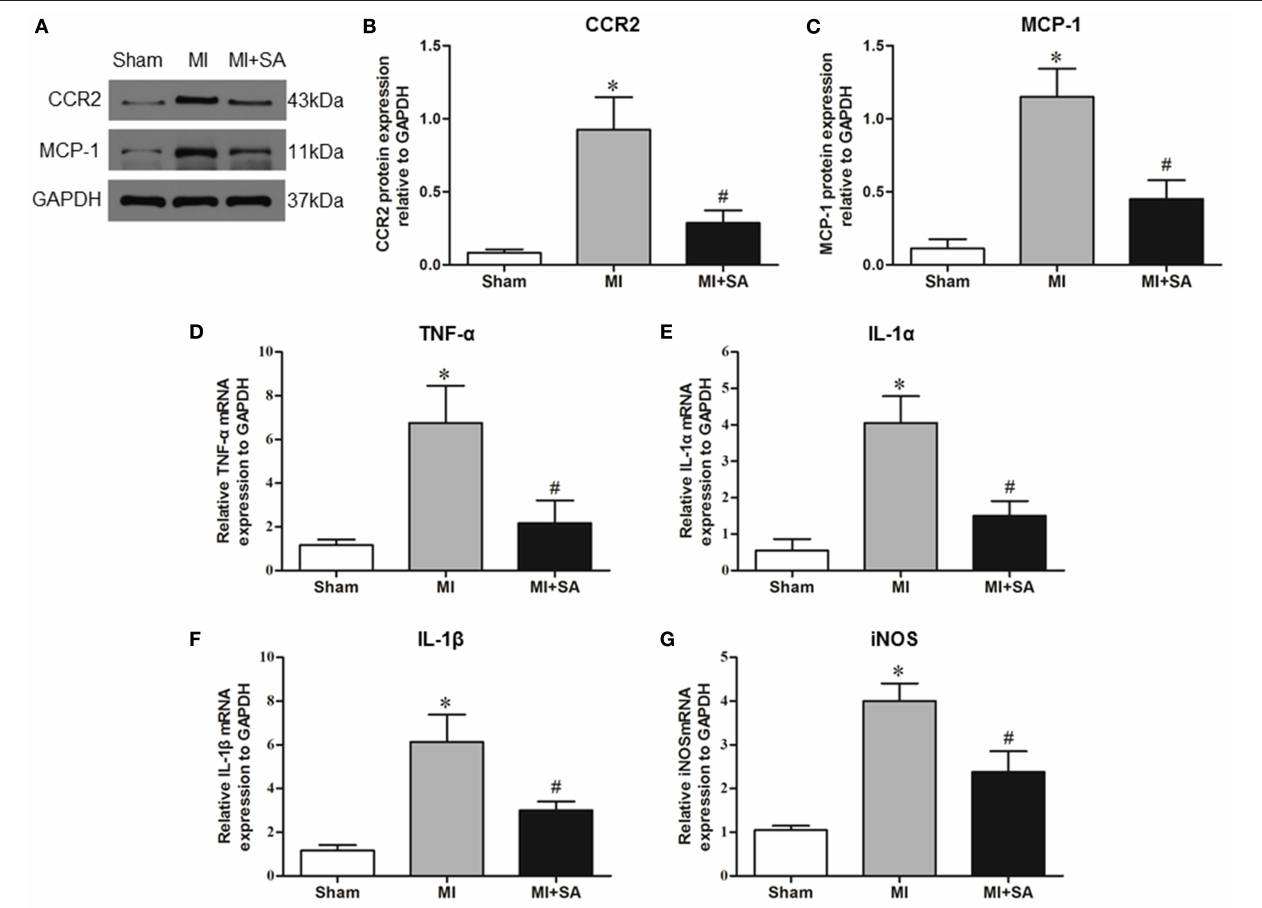
FIGURE 2 | SA inhibited inflammatory factors at 1 week after MI. (A–C) MCP-1 and CCR2 in the three groups were detected by Western blot. (D–G) Levels of the inflammatory factors TNF- α , IL-1 α , IL-1 β , and iNOS were detected by RT–qPCR. *Compared with the sham group, P < 0.05, # Compared with the MI group, P < 0.05, n = 8 in each